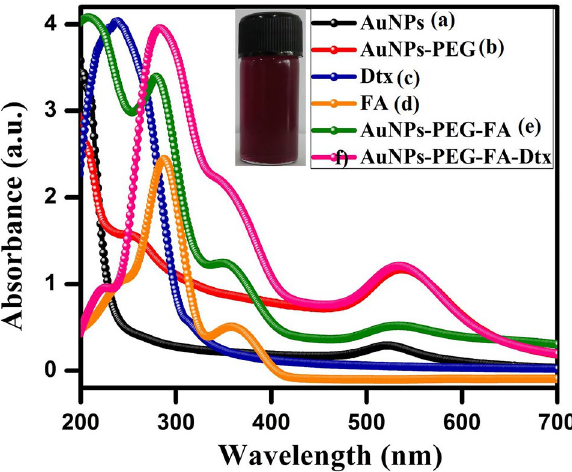
Figure 2. UV–Vis absorption spectra of the synthesized gold nanoformulations ( a ) AuNPs (λmax = 527 nm), ( b ) AuNPs-SH-PEG-NH 2 (λmax = 528 nm), ( c ) Dtx (λmax = 231 nm), ( d ) FA (λmax = 277 and 344 nm), ( e ) AuNPs-PEG-FA (λmax = 277, 344 and 528 nm) and ( f ) AuNPs nanoformulations (λmax = 228, 277, 344 and 528 nm) and inset photographic image of gold nanoformulations at pH =